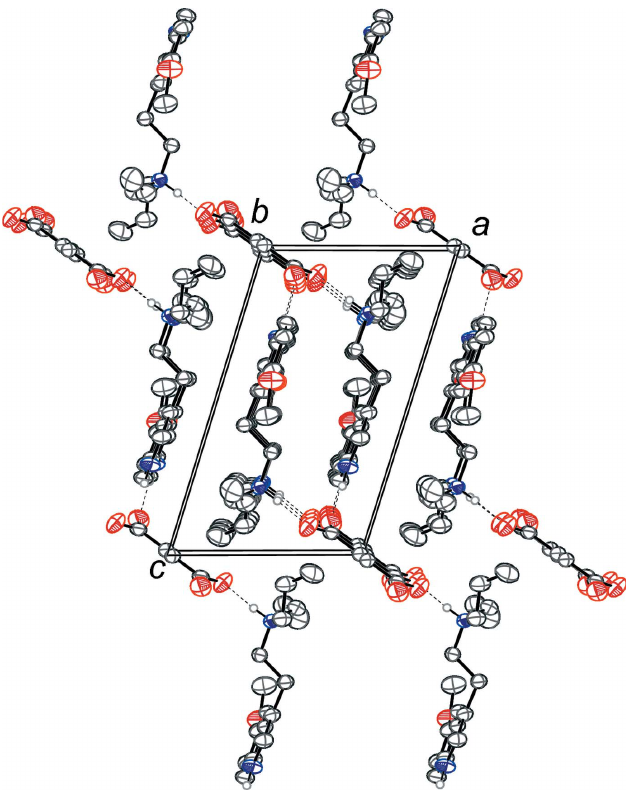
Figure 1 The molecular structure of bis(5-methoxy- N , N -diallyltryptammonium) fumarate, showing the atom labelling. Displacement ellipsoids are drawn at the 50% probability level. Hydrogen bonds are shown as dashed lines. Symmetry code: (i) (cid:3) x , 1 (cid:3) y , (cid:3) z